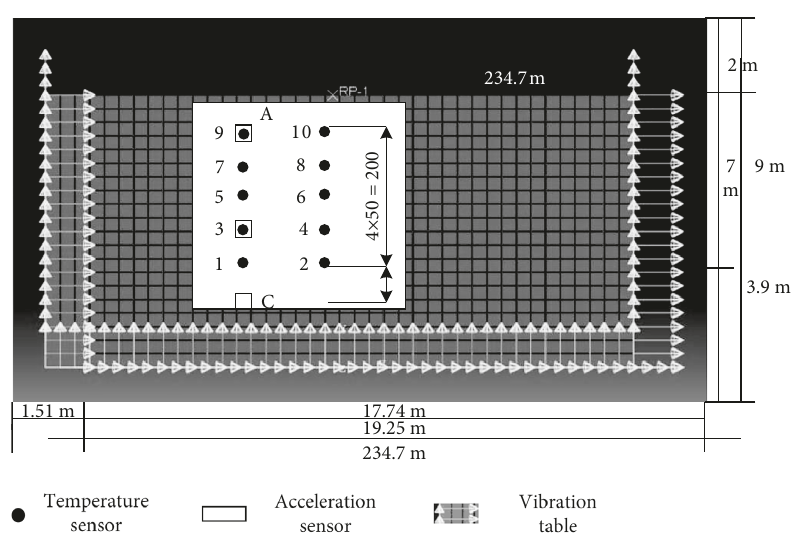
Figure 2: Load effect analysis model of bridge pile foundation and